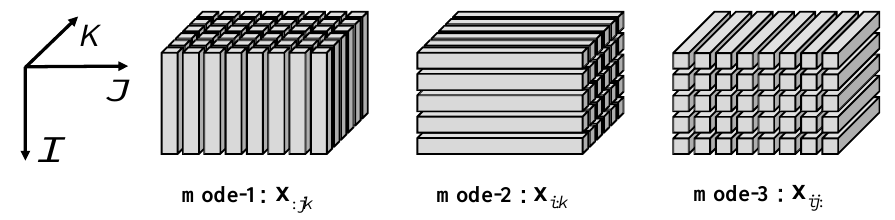
Figure 1. Fibers of a third-order tensor